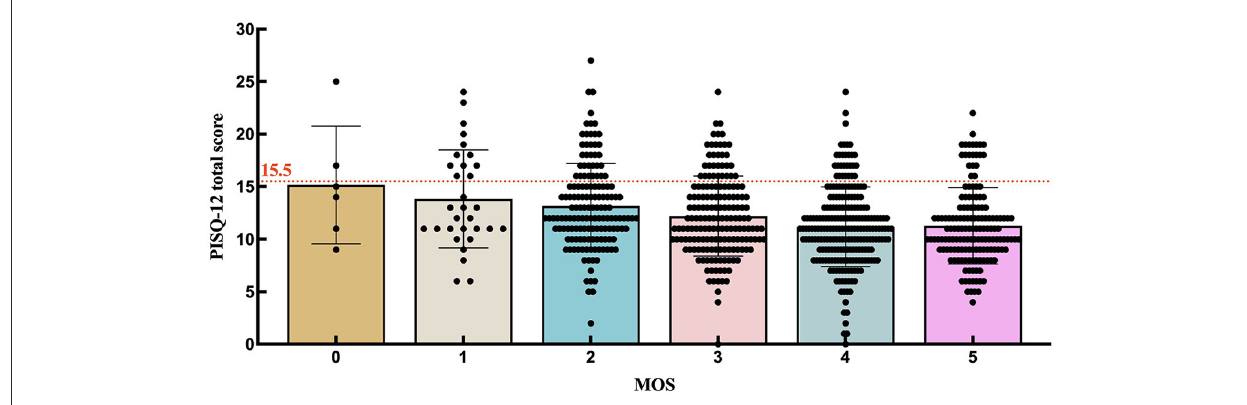
FIGURE2 Distribution of PISQ-12 scores among participants with each MOS grade.